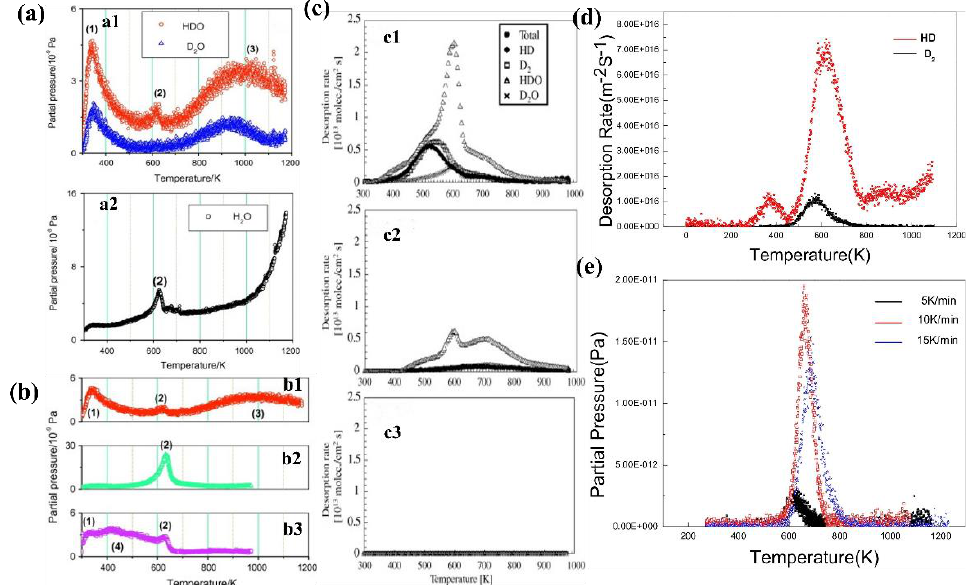
Figure 7. ( a ) TDS spectra for Li 2 TiO 3 single crystal plate sample (thickness of 0.2–0.4 mm): ( a1 ) HDO and D 2 O; ( a2 ) H 2 O. ( b ) Comparison of HDO peaks for Li 2 TiO 3 single crystal samples: ( b1 ): 0.984 g for the plate; ( b2 ) 0.031 g for 50 µ m powder; ( b3 ) 0.040 g for 5 µ m powder. Reprinted with permission from ref. [96] ( c ) Thermal desorption spectra of gases containing deuterium for deuterium ion irradiated Li 2 TiO 3 pebbles at the irradiation temperatures of ( c1 ) RT, ( c2 ) 573 K, and ( c3 ) 773 K. Reprinted with permission from ref. [97]. ( d ) Comprehensive TDS spectrum for HD and D 2 released from Li 2 TiO 3 with a heating rate of 15 K/min. ( e ) TDS spectrum for D 2 released from Li 2 TiO 3 . Reprinted with permission from ref.